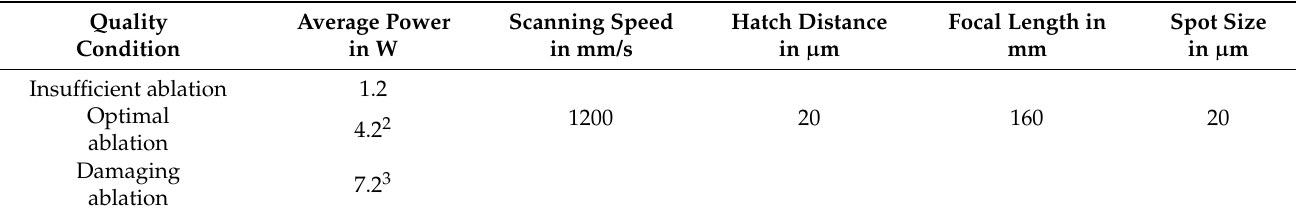
Table 1. Laser parameters used in this work for treating the different parts.